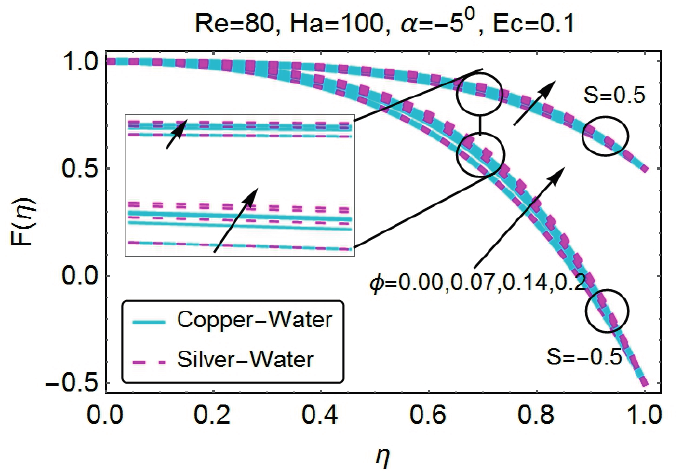
Figure 9. Change in velocity for varying ϕ (convergent